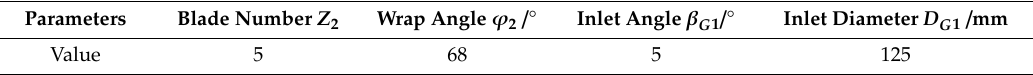
Table 4. Main geometric parameters of the original positive guide